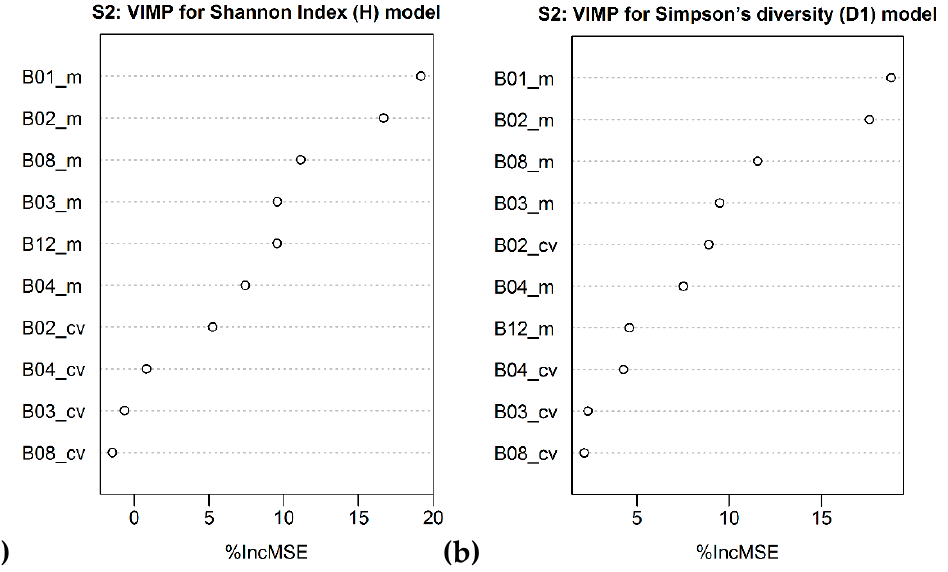
Figure 3. Importance of Sentinel-2 MSI bands using the percentage increase in mean squared prediction error (%IncMSE) for ( a ) Shannon’s ( H’ ) and ( b ) Simpson’s diversity ( D1 ) indices. Higher %IncMSE indicates greater variable importance.